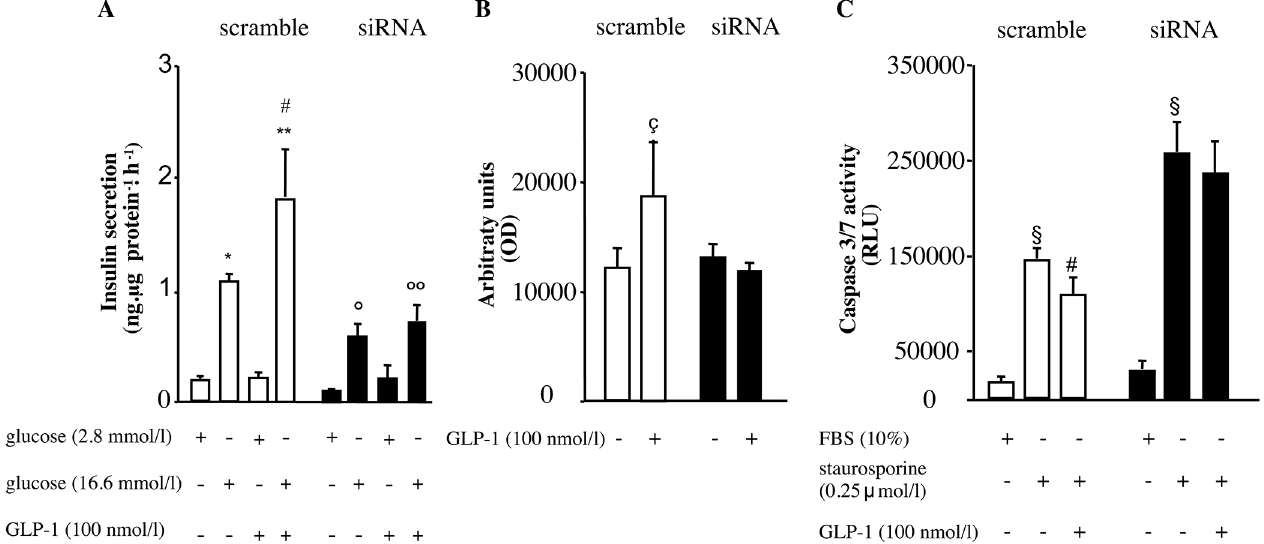
Fig 4. GLP-1 effectson insulin secretion, proliferation and apoptosis are impaired in insulin receptorknockdown cells. Panel A. Insulin secretion in INS-1E cells, transfected with insulinreceptor siRNA. Cells were incubatedwith 2.8 or 16.6 mmol/l glucosein the absenceor presence of GLP-1 (100 nmol/l). Values are expressedas means ± SD of three independentexperiments ( * p < 0.05vs. scramble cells exposedto 2.8 mmol/l glucose; ** p < 0.05vs. scramble cells exposedto 2.8 mmol/l glucoseplus 100 nmol/l GLP-1; #vs. scramble cells exposedto 16.6 mmol/l glucose; ˚p < 0.05vs. siRNA cells exposedto 2.8 mmol/l glucose;˚˚ siRNA cells exposedto 2.8 mmol/l glucoseplus 100 nmol/l GLP-1). Panel B. Cell proliferation, assessed by BrdU incorporation, in INS-1E cells transfected with insulinreceptor siRNA. Cells were switched to serum free medium for 12 hours and then incubatedfor 48 hours in the absenceor presenceof GLP-1 (100 nmol/l). Values are expressedas means ± SD of four independentexperiments, each comprisingthree wells (c¸ p < 0.05vs. untreatedscramble cells). Panel C. Apoptosis, assessed by caspase 3/7 activity, in INS-1E cells transfected with insulinreceptor siRNA. Cells were treated with staurosporine (0.25 μ mol/l, 2 hours) in the absenceor presence of 100 nmol/l GLP-1. Treatment with GLP-1 significantly decreased apoptosisinducedby staurosporine in scramble control cells but not in siRNA transfected cells. Values are expressedas means ± SD of nine independentexperiments, each comprisingthree wells. (§ p < 0.05vs. untreatedscramble or siRNA transfected cells; # p < 0.05vs. scramble cells treated with staurosporinein the absenceof GLP-1).